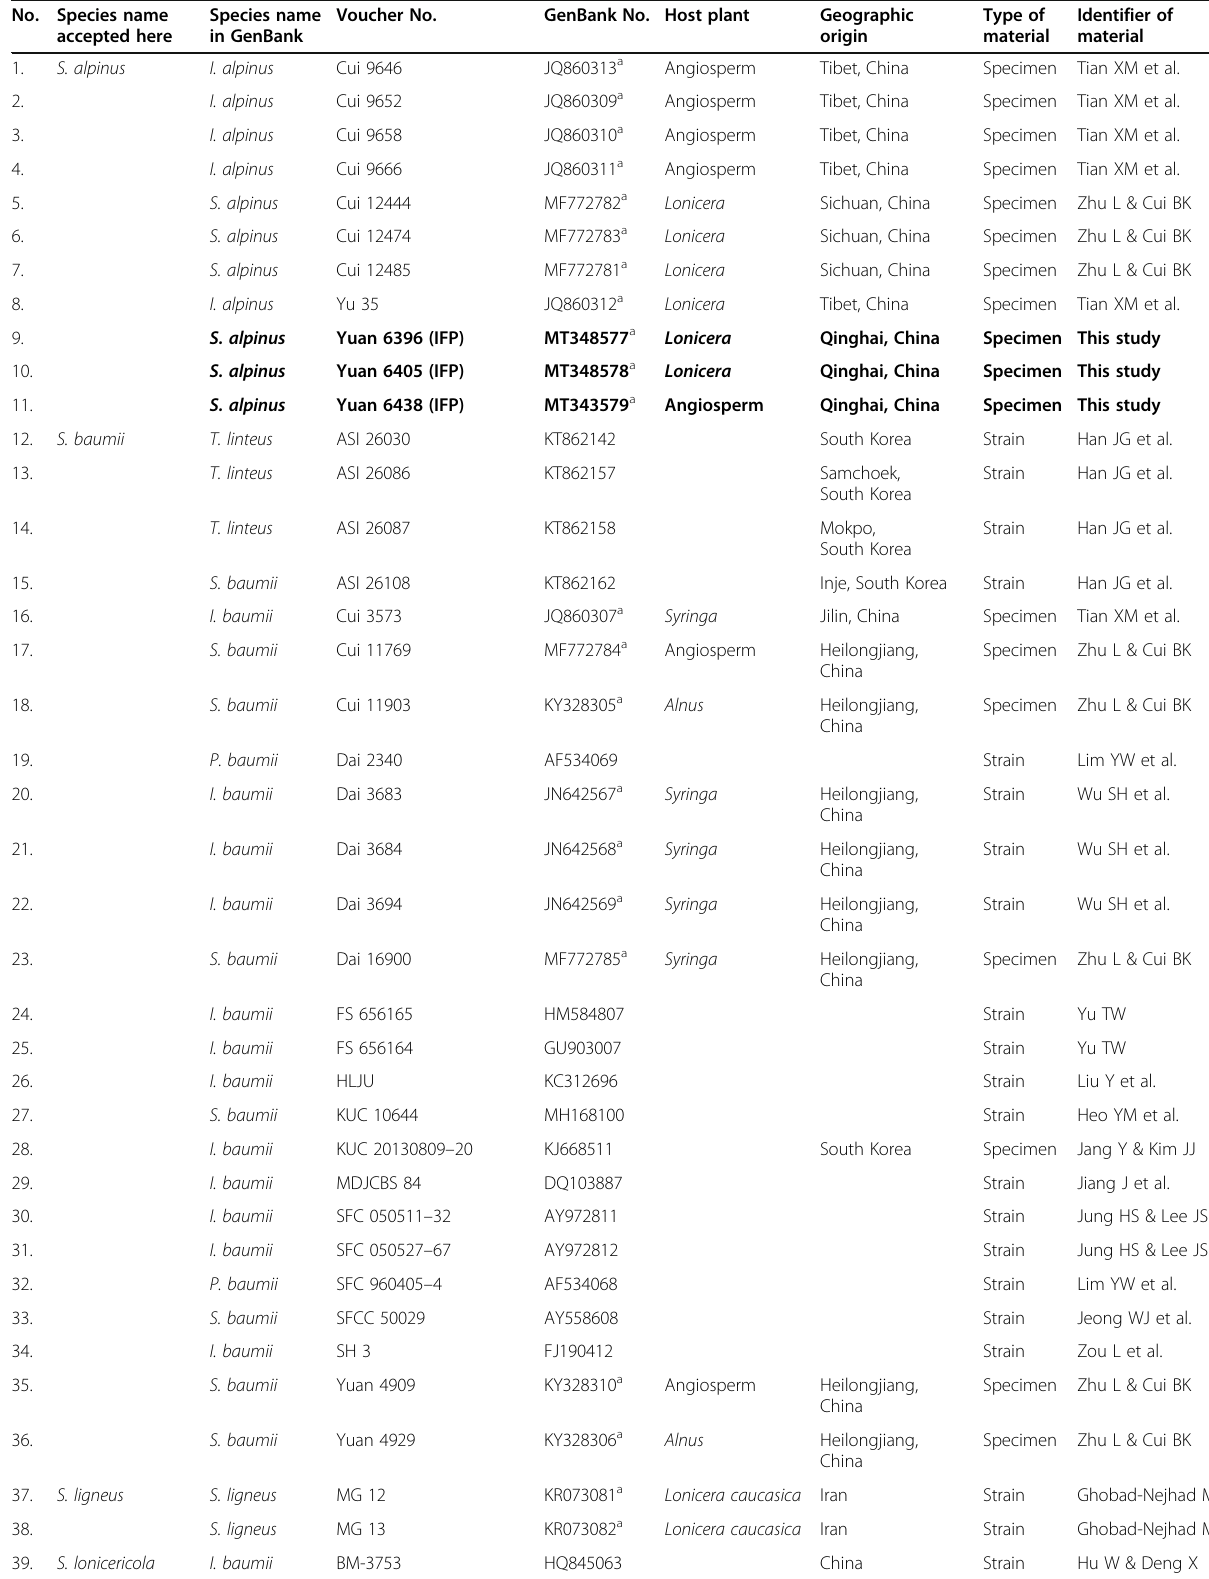
Table 1 Information of analyzed ITS sequences of